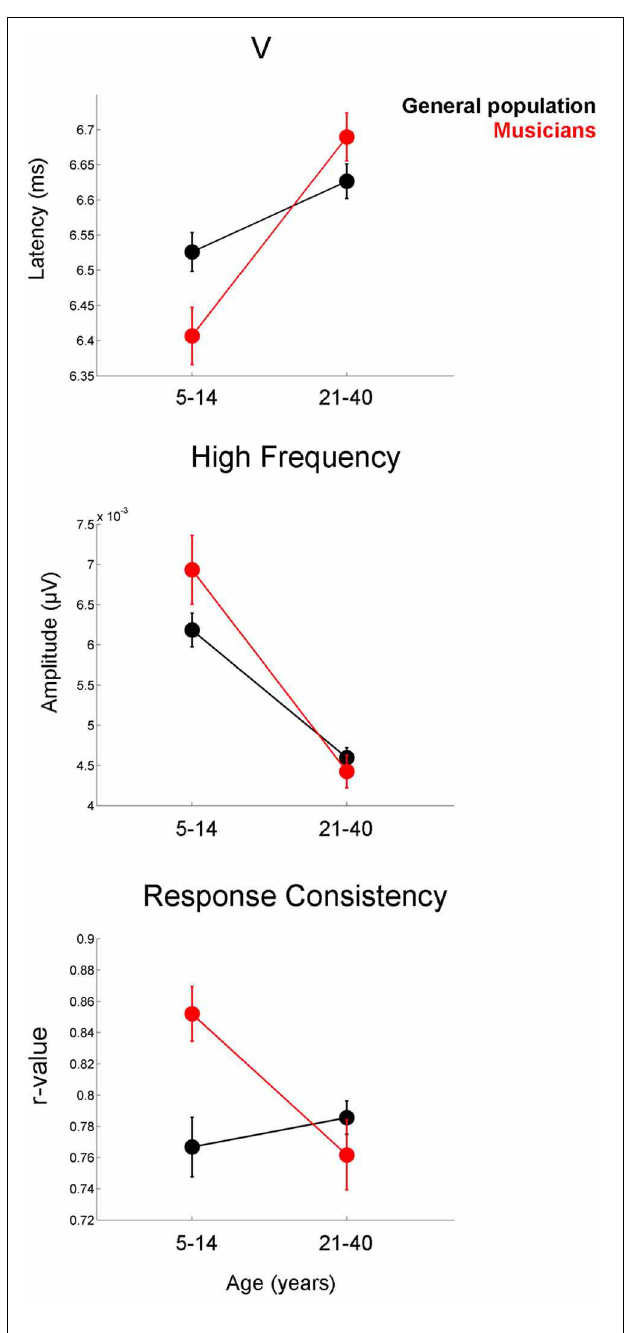
FIGURE 6 | Musicians (red) display greater developmental overshoot than the general population (black). This effect is present for the latency of peak V (top) , the amplitude of the high-frequency region of the frequency-following response (middle) , and response consistency (bottom) . Comparisons are made between the 5–14 year-old group and the 21–40 year-old groups. For all three measures, the difference between the child and adult values is greater in the musicians than in the general public. Error bars represent + / − one standard error of the mean.